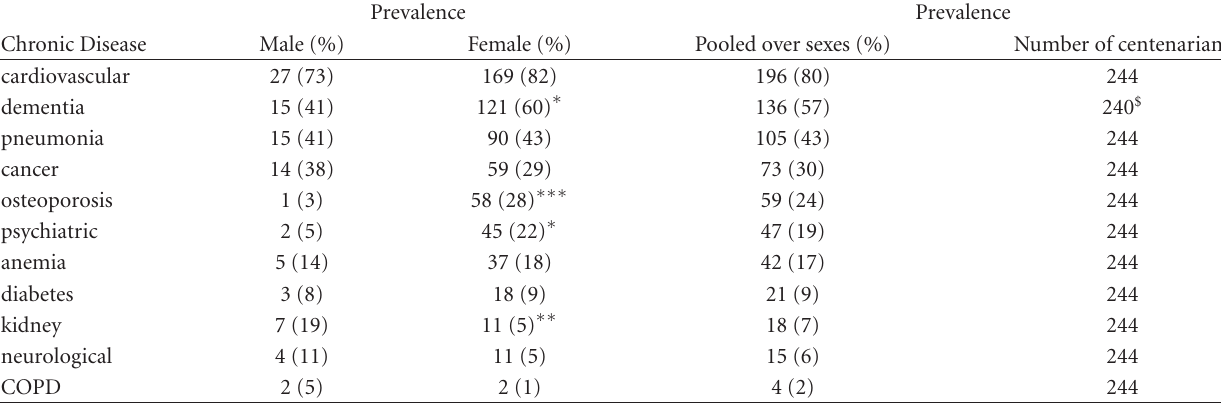
Table 5: Lifetime Prevalence of chronic diseases among centenarians in the GCS.